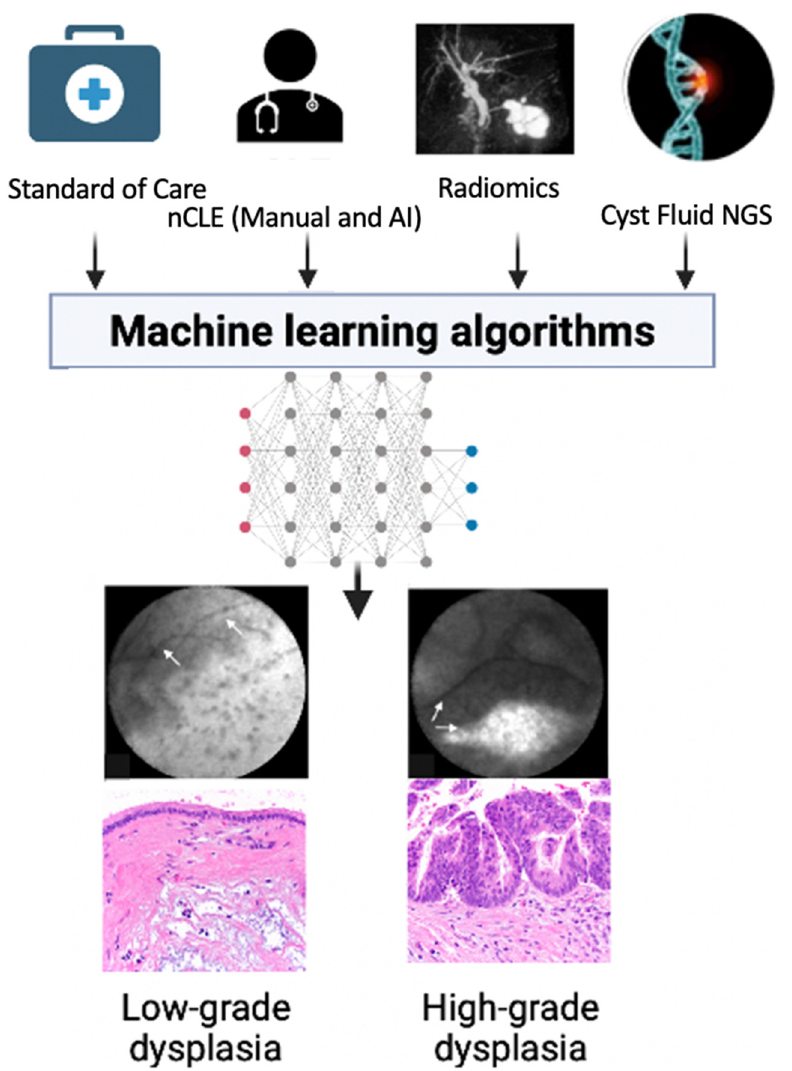
Figure 3. Integration of diagnostics for the prediction of HGD-Ca: Standard of care (SOC) vari- ables: Demographics and patient characteristics; age, gender, onset of diabetes, family history symptoms, pancreatitis history, serum CA 19-9, and cyst fluid analysis (glucose, CEA, cytology). Cyst and pancreas morphology: CT/MRI/EUS: size, wall, thickness, mural nodules, growth rate, and pancreatic duct diameter. nCLE: needle-based confocal laser endomicroscopy. NGS: Next generation sequencing.